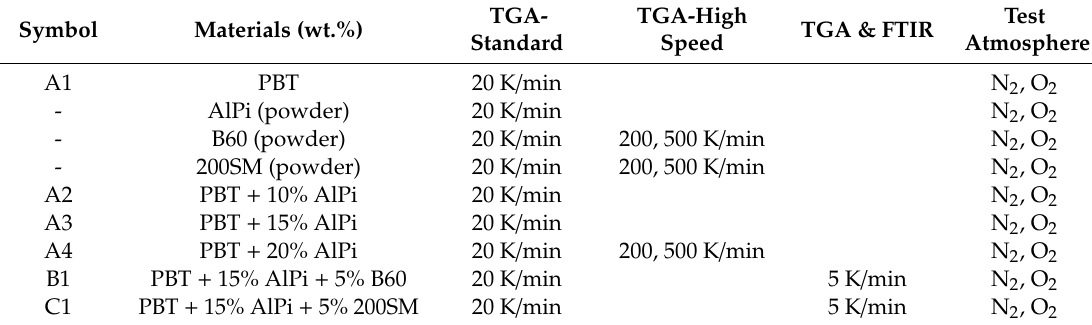
Table 2. Heating rates and test atmospheres thermogravimetric analysis (TGA) and TGA-fourier transformation infrared spectroscopy (TGA-FTIR)